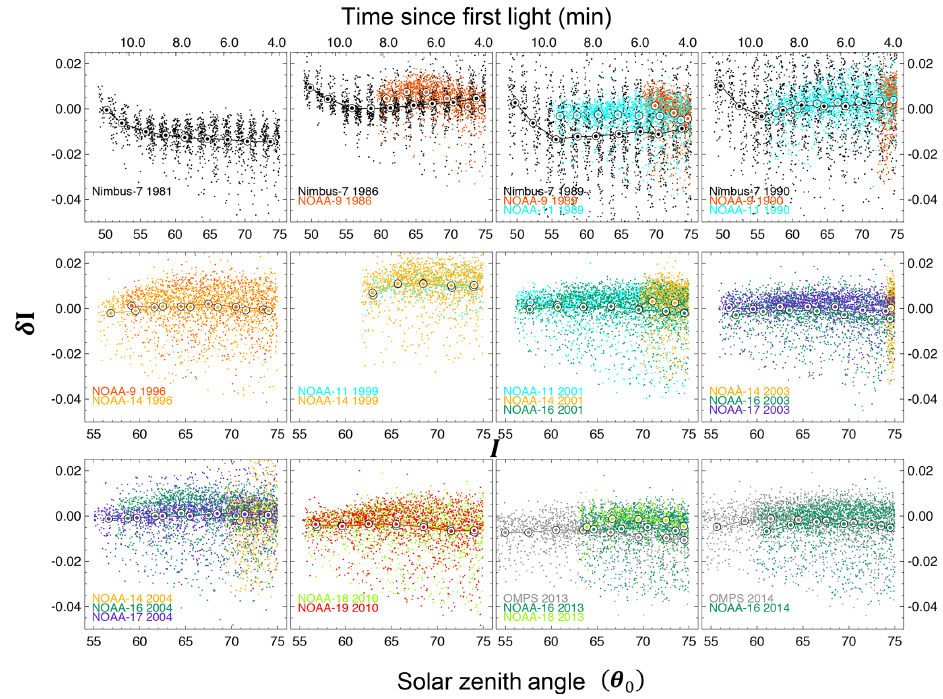
Figure 5. Empirically calibrated δI for all FOVs observed over Antarctica plotted against solar zenith angle ( θ o ) for selected years. The top four panels show the suppression of δI during the first 7–10min after Nimbus-7 sees its first light at the start of a new orbit. At first light, time = 0 and θ o = 90 ◦ . The time after first light (minutes) is shown at the top of the first four panels.